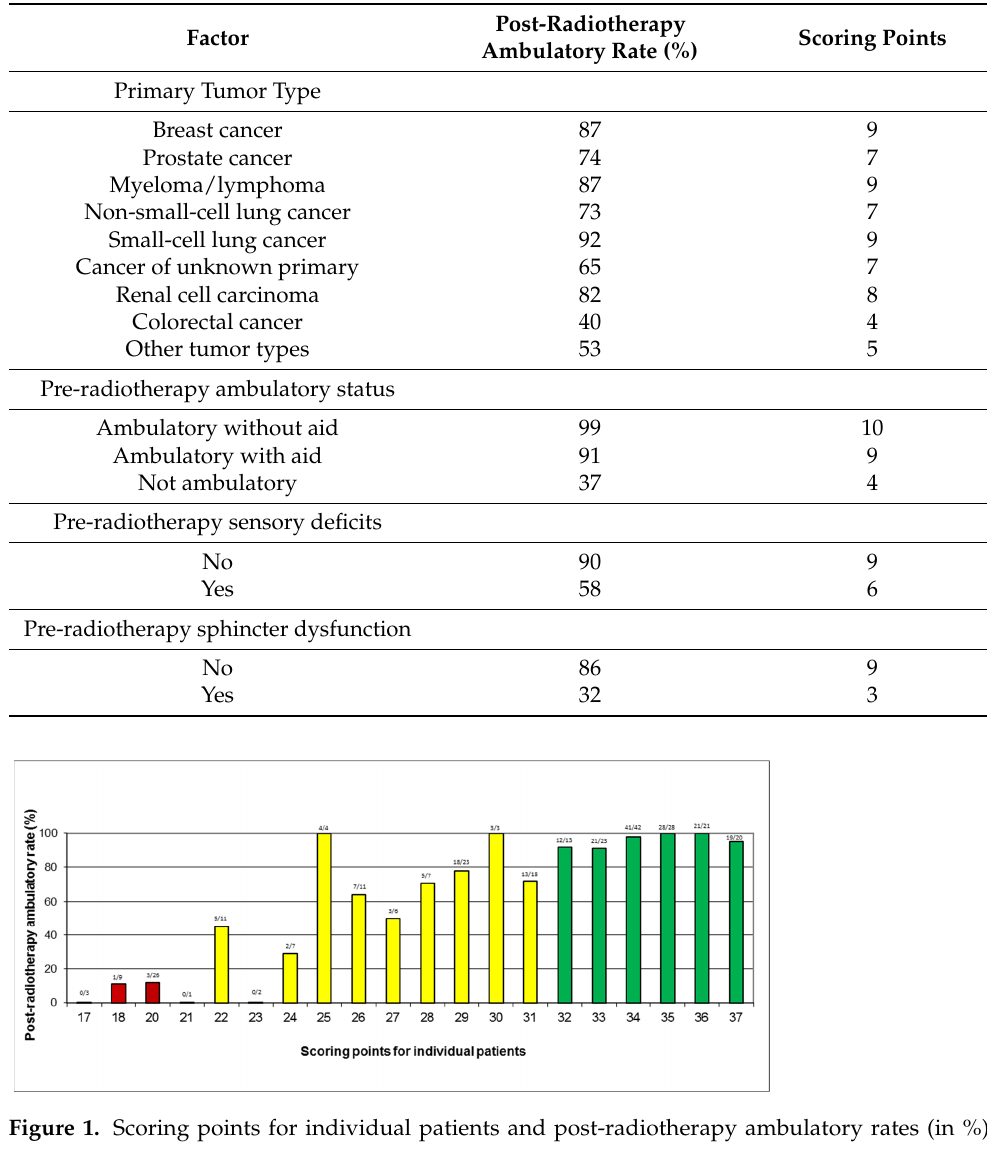
Table 3. Scoring points assigned to the prognostic factors included in the scoring instrument.